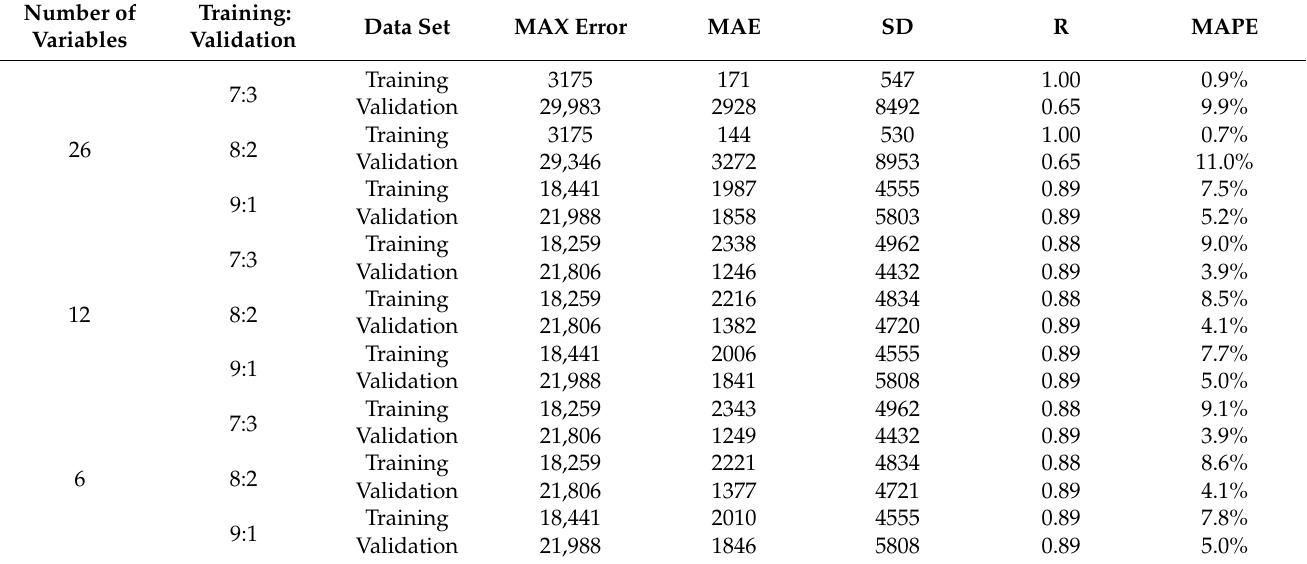
Table A8. Analysis of the results of the ECHAID model for electricity consumption.